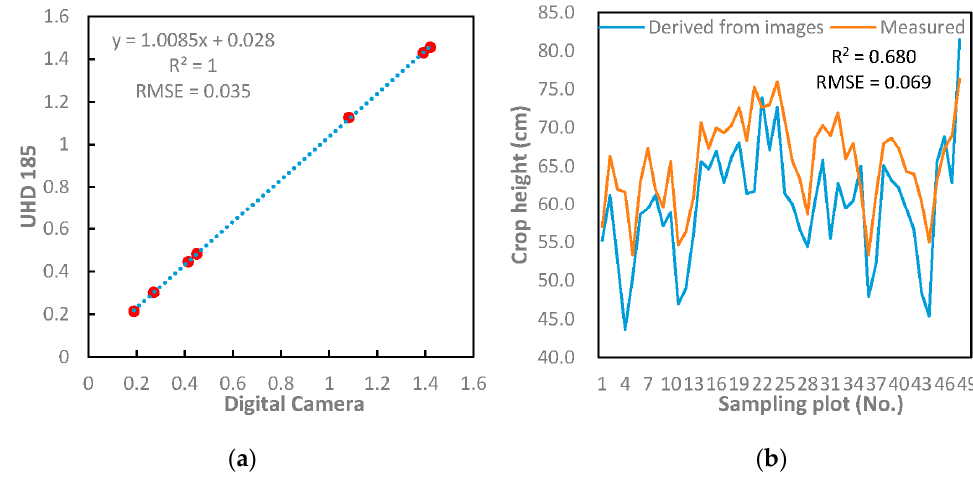
Figure 11. ( a ) Comparison between PAN image DOM-derived and digital RGB image DOM-derived ground feature lengths; ( b ) crop height derived from the hyperspectral DEM (Height 1) and field-measured data (Height 2).